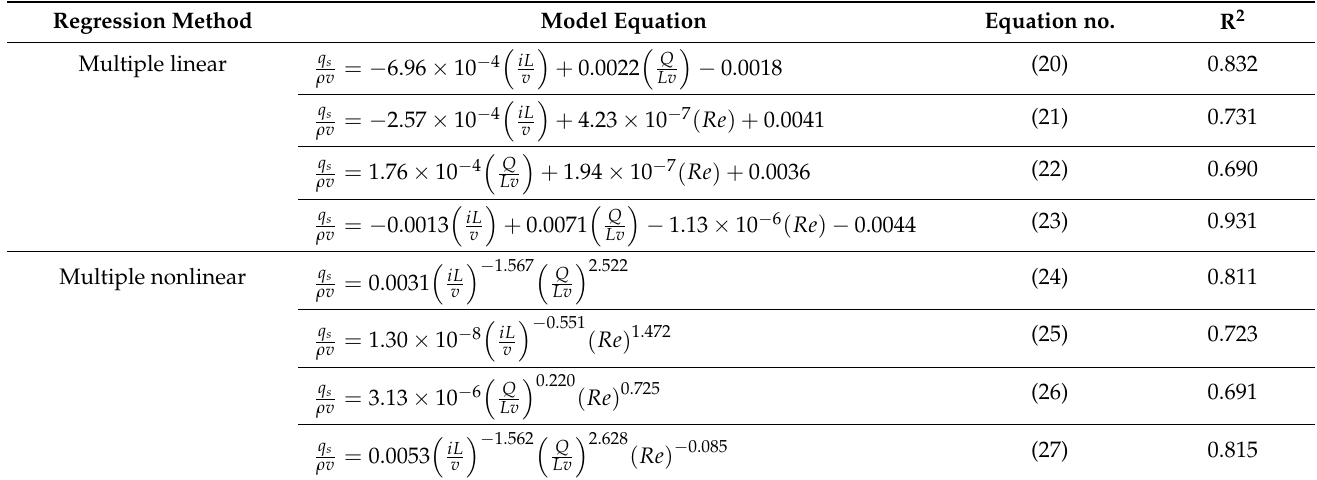
Table 10. The results of the multiple regression analysis show best-predicted transport